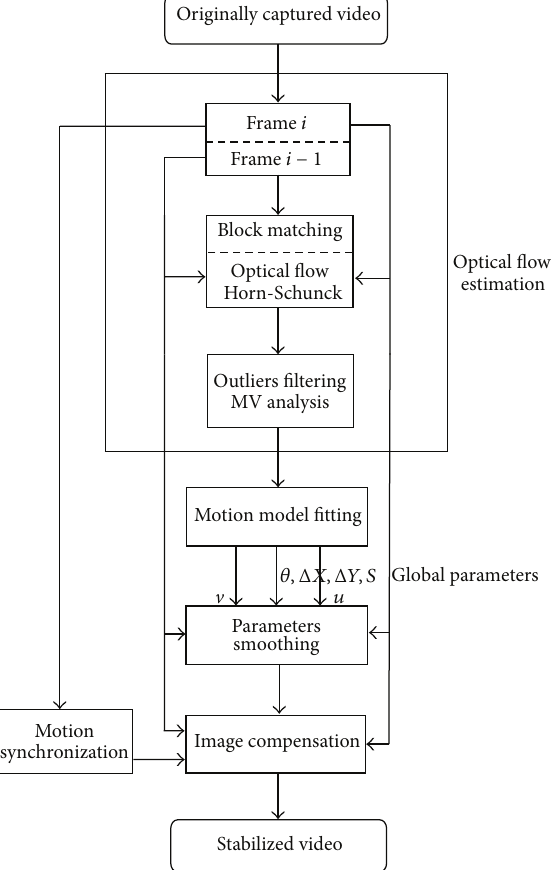
Figure 1: Flowchart of the video stabilization